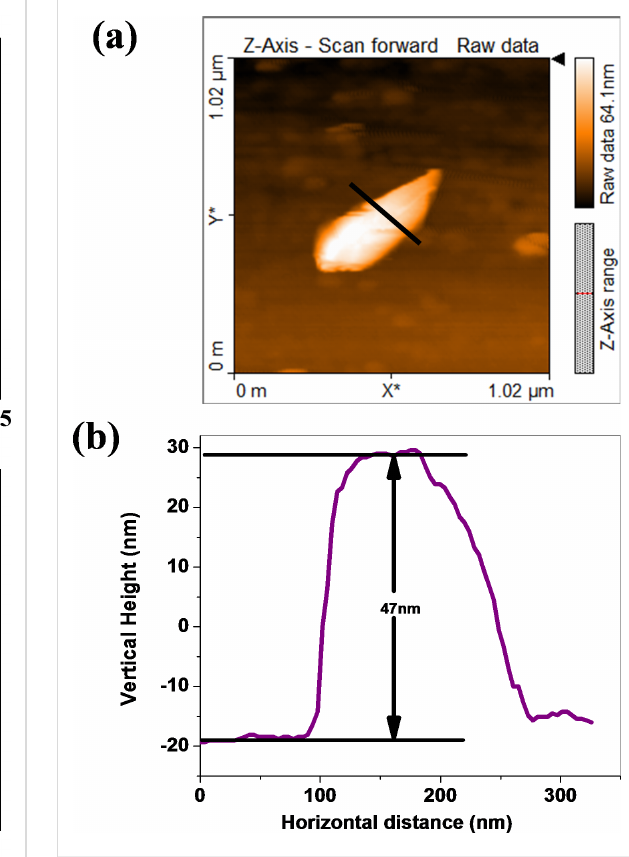
Figure 5: (a) AFM image and (b) AFM height profile plot for a PtSe 2 nanosheet. The Raman phonon frequency as a function of volume and tem- perature is given by Equation 2